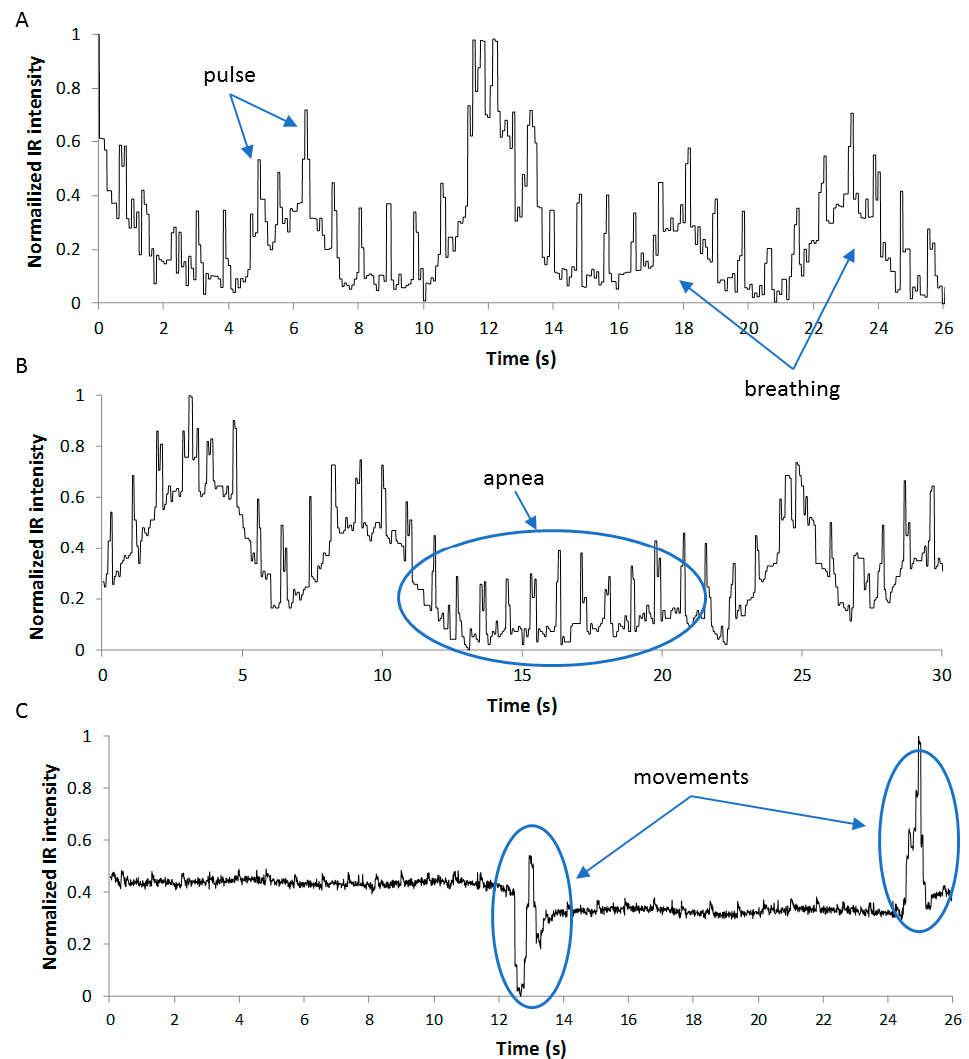
Figure 6. Example of obtained BCG curves. Subject in supine ( A ) and prone ( B ) positions; sequence corrupted by the activity of the patient ( C ).